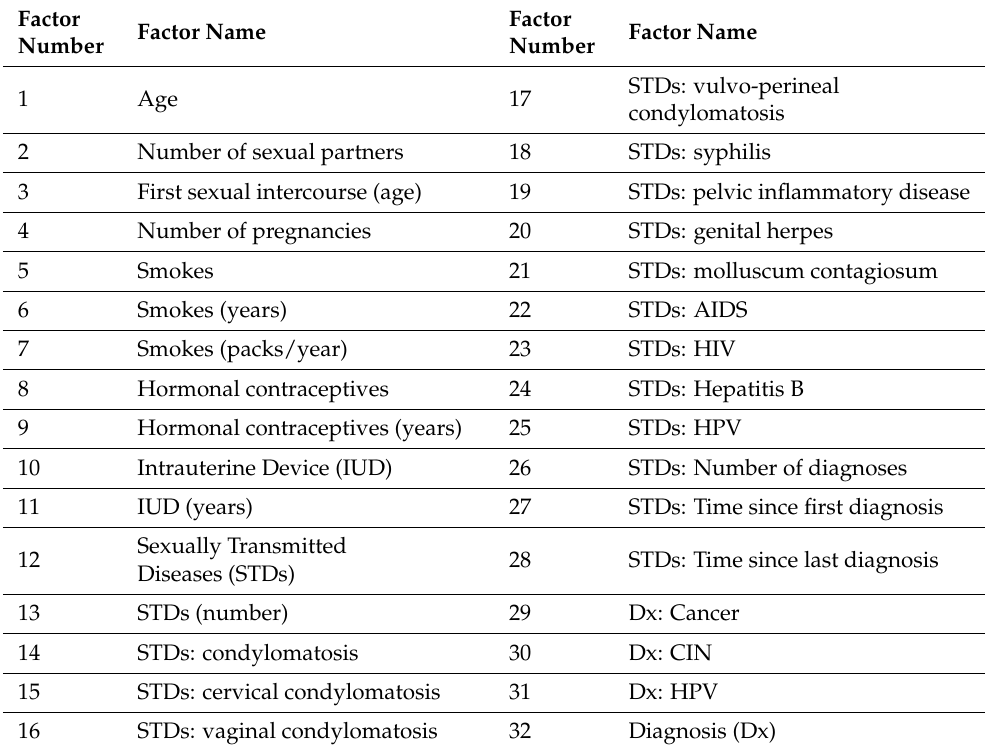
Table 1. Risk factors of cervical